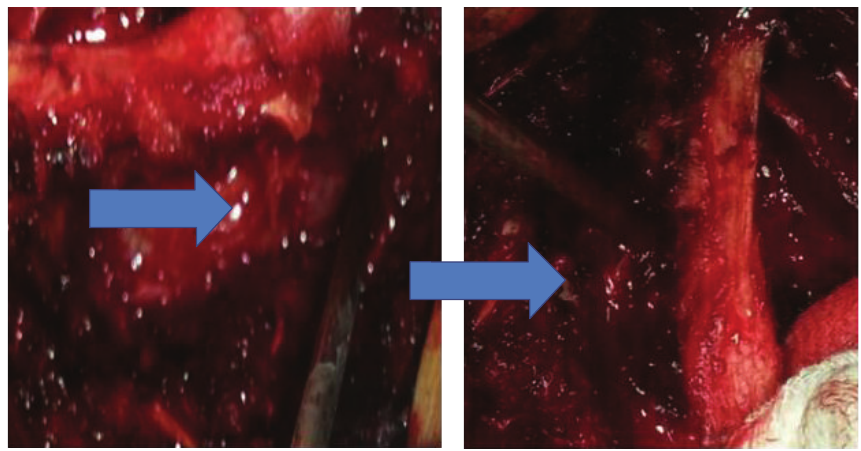
Figure 2: Thoracic spinal epidural hematoma images during